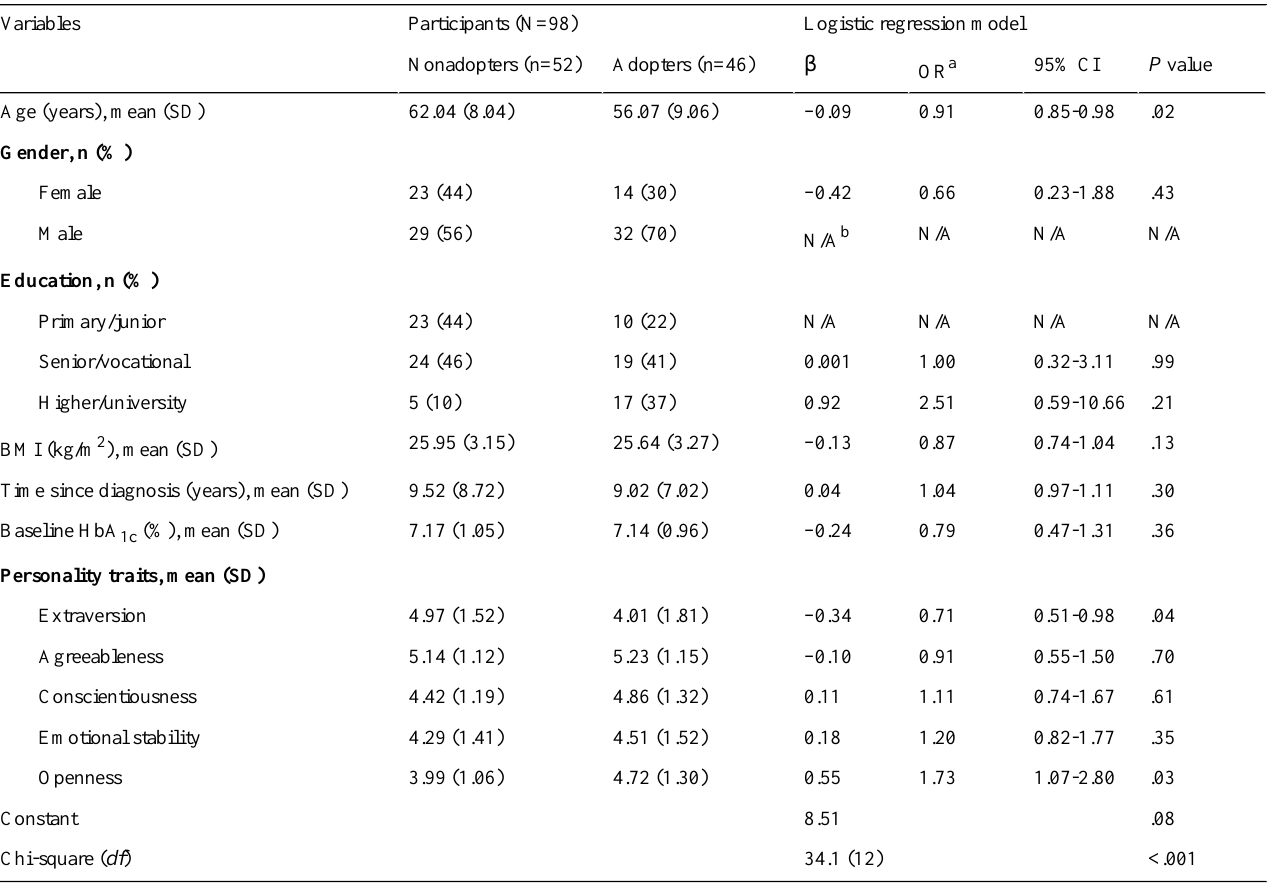
Table 2. Logistic regression for personality traits associated with adoption preference.